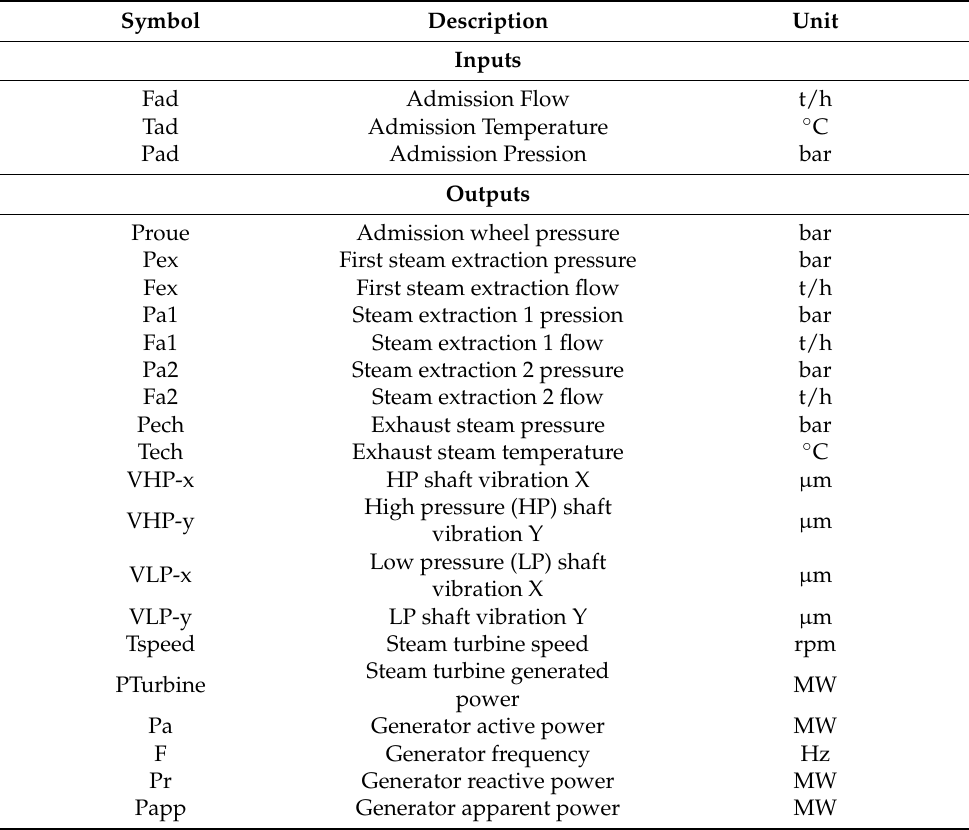
Table 4. Input dataset